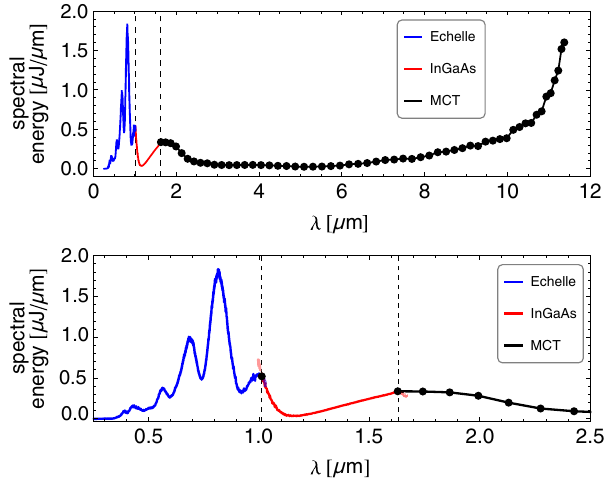
FIG. 19. (a) Combined measured TR spectrum: The Echelle and MCT spectra are rescaled in their intensities according to overlap wavelengths to the InGaAs spectrum. The overlap wavelengths are λ ¼ 1 . 0 μ m and 1 . 63 μ m for Echelle and MCT spectra, respectively. (b) depicts a zoomed-in spectrum with InGaAs (pink) and Echelle data (transparent blue) beyond their designated spectral domains in regions of overlapping wavelengths.